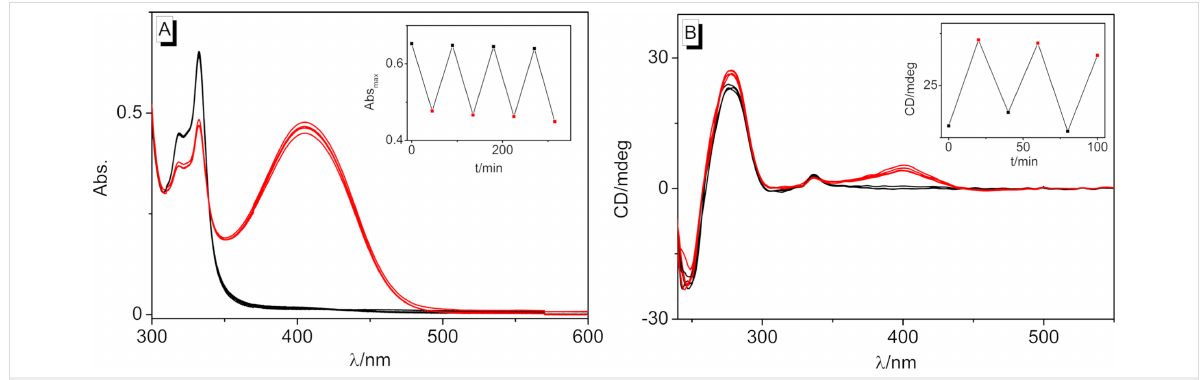
Figure 10: A) Photometric and B) CD spectroscopic monitoring of the photoinduced switching ( 4b : λ ex = 315 nm, 3b : λ ex = 450 nm) between 4b ( c = 20 µM, black) and 3b (red) in the presence of ct DNA ( c = 20 µM) in BPE buffer. DNA concentration in base pairs.